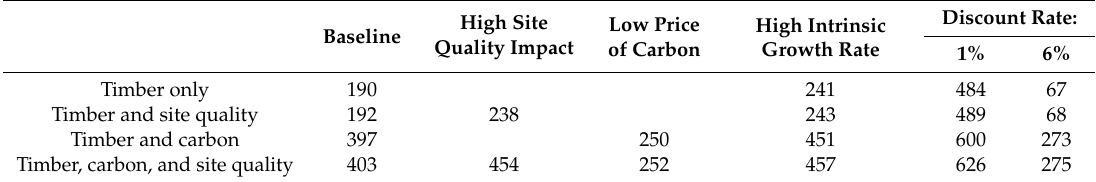
Table 2. Comparison of NPV between baseline and di ff erent values of site quality impact, carbon price, intrinsic growth rate, and discount rate, in thousand SEK /